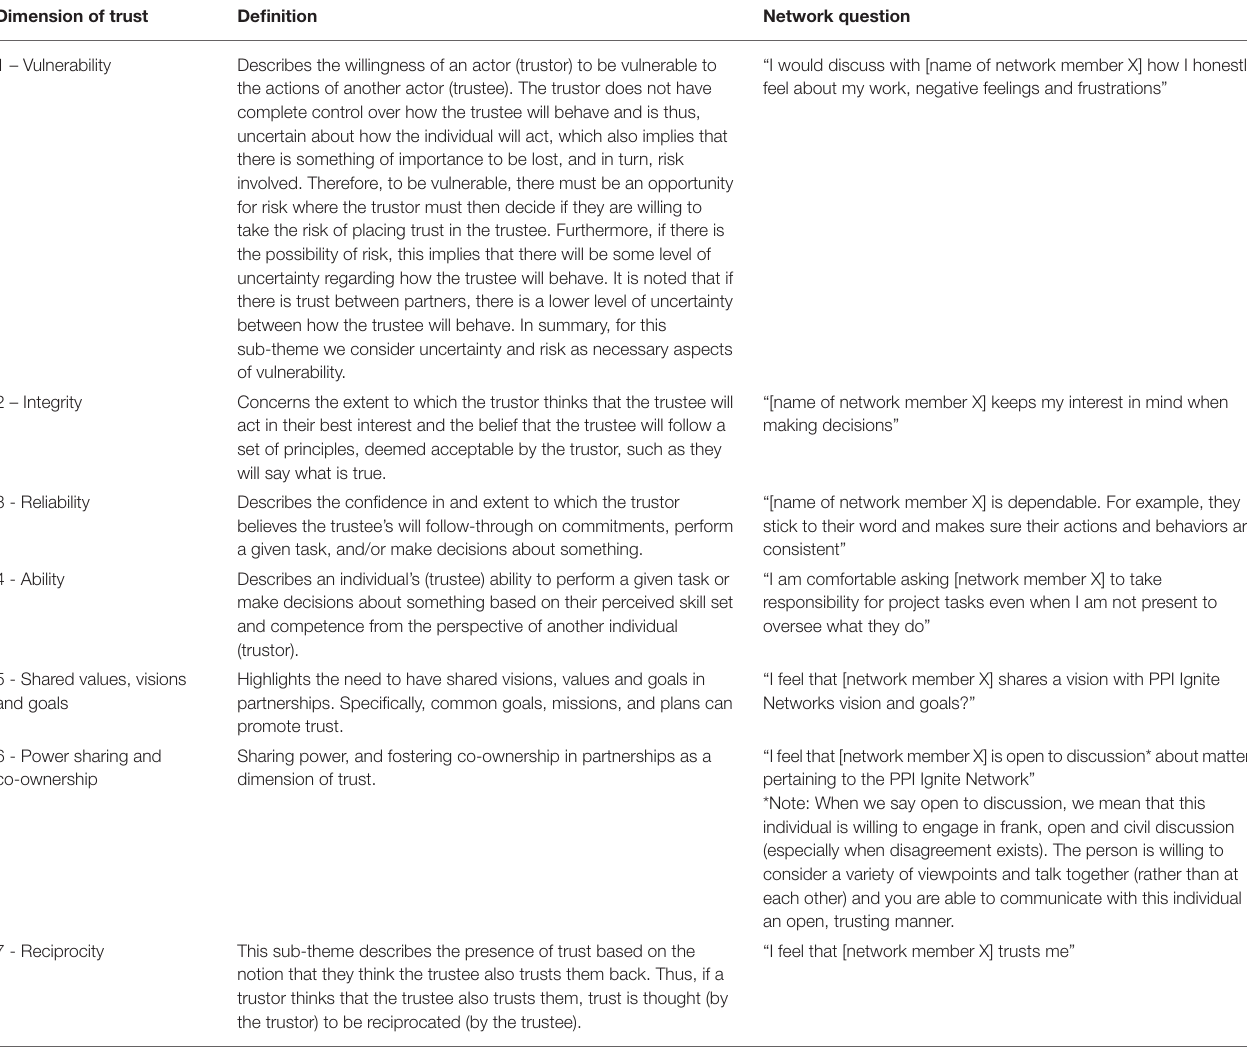
TABLE 1 | Descriptions of trust dimensions [based on Gilfoyle et al. (9)]. Dimension of